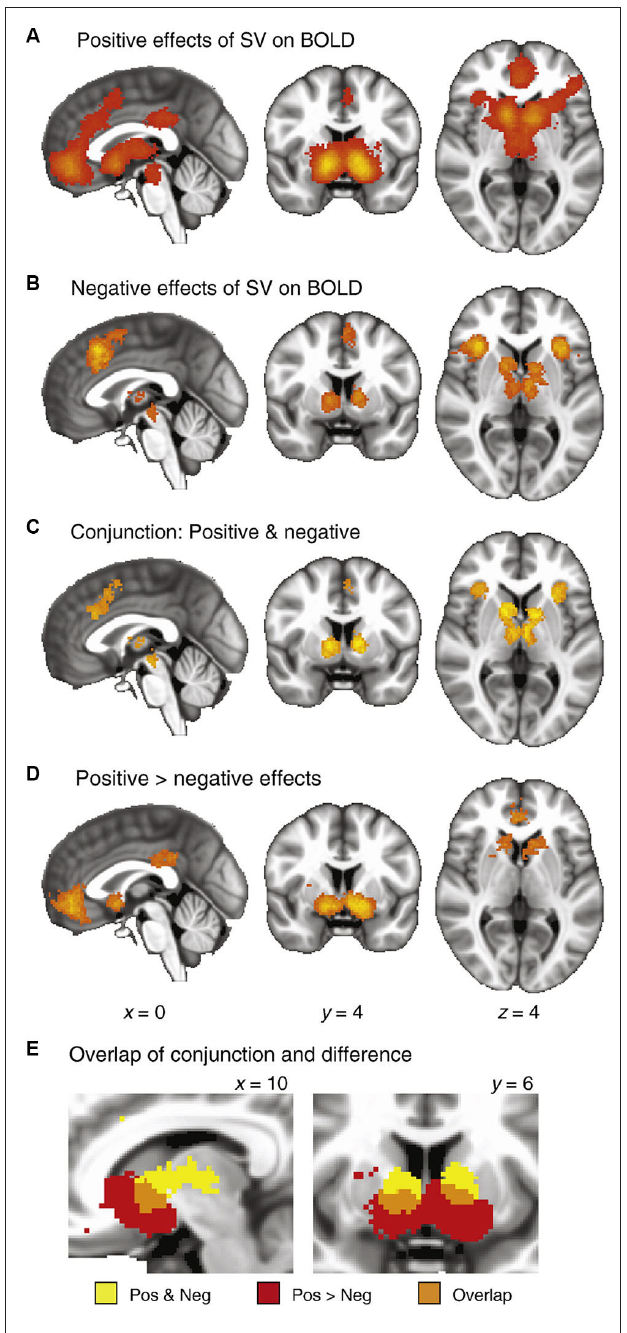
FIGURE 1 | Meta-analysis of fMRI studies of value (taken from Bartra et al., 2013) . The authors extracted peak coordinates of activation from 206 published fMRI studies that investigated value computations. (A) Significant clustering of positive responses. (B) Significant clustering of negative responses. (C) Conjunction maps, showing regions with significant clustering for both positive and negative responses. (D) Results of a between-category comparison, showing regions with significantly greater clustering for positive than negative effects. (E) Detail of the striatum, illustrating overlap between the conjunction map ( Panel C ) and the difference map ( Panel D ). These data demonstrate the relative response of anterior insula, striatum and ventromedial PFC to positive and negative